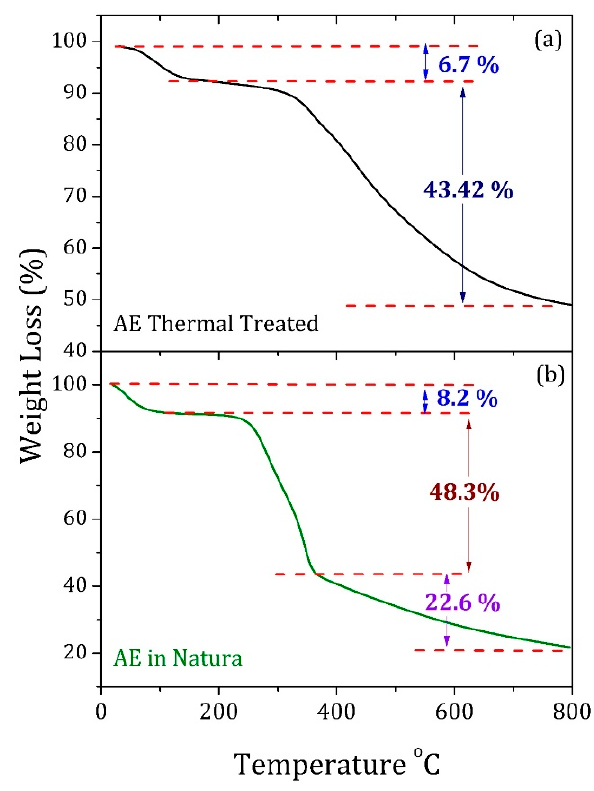
Figure 5. Thermogravimetric (TG) curve of the ( a ) thermal treated and ( b ) untreated AE. Materials 2020 , 13 , x FOR PEER REVIEW